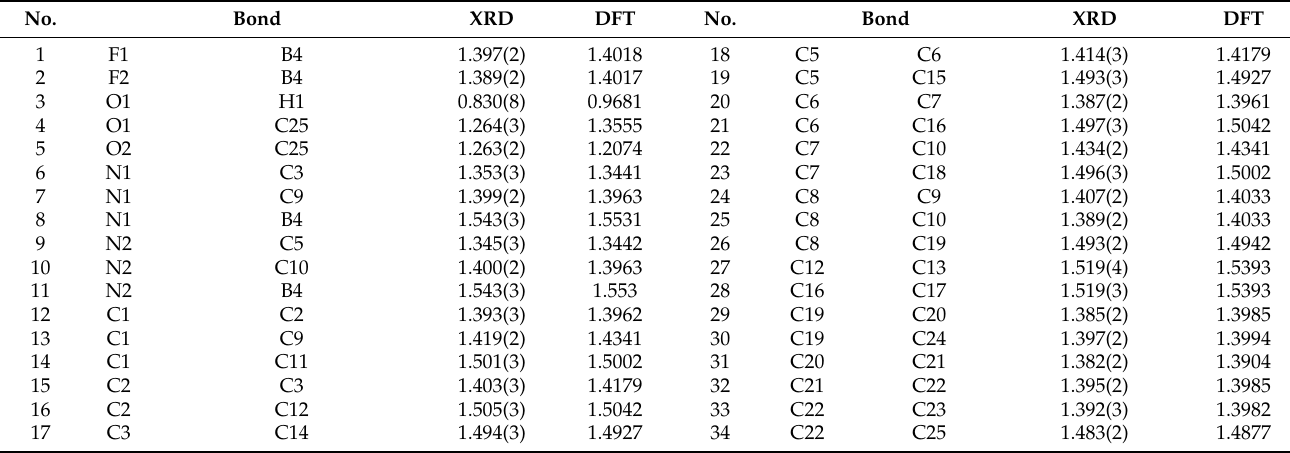
Figure 2. Tetrahedral of B-complex structures: ( a ) ORTEP and ( b ) DFT-optimized. Table 2. DFT/XRD bond lengths (Å), angles ( o ), and dihedral angles ( o